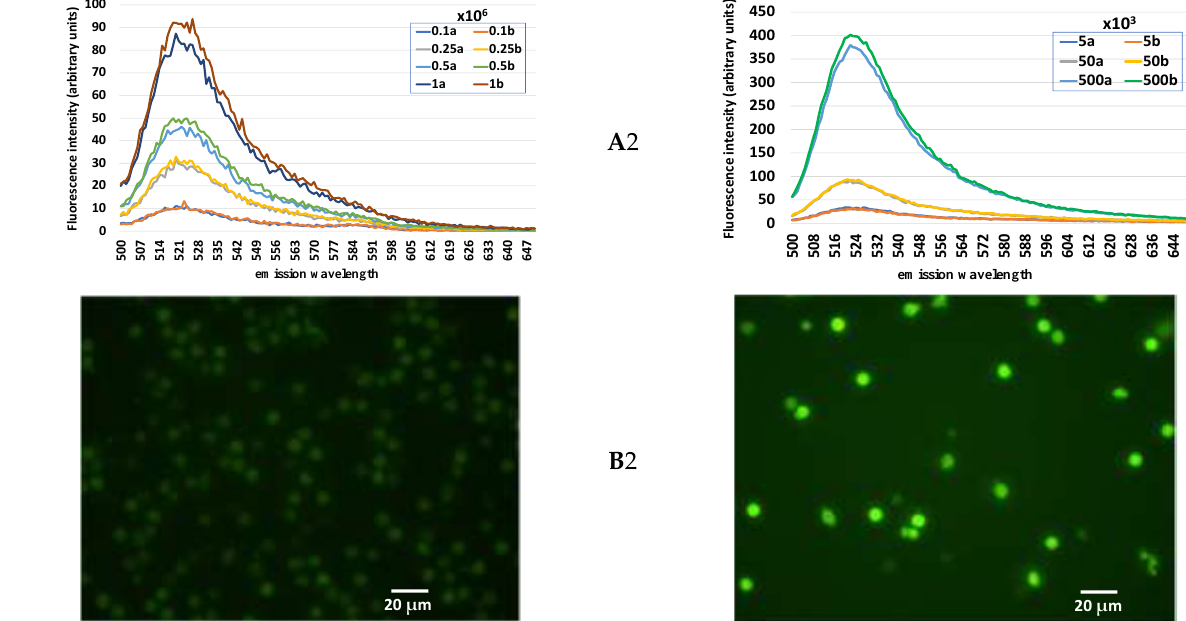
Figure 1. Fluorescence spectra obtained from samples of equine endometrial cells ( A 1) and leukocytes ( A 2) loaded with 2′,7′-dichlorodihydrofluorescein (H 2 DCF-DA) and excited at 490 nm wavelength at increasing cell concentration and in duplicate. Fluorescence images of equine endometrial cells ( B 1) and leukocytes ( B 2) loaded with H 2 DCF-DA.